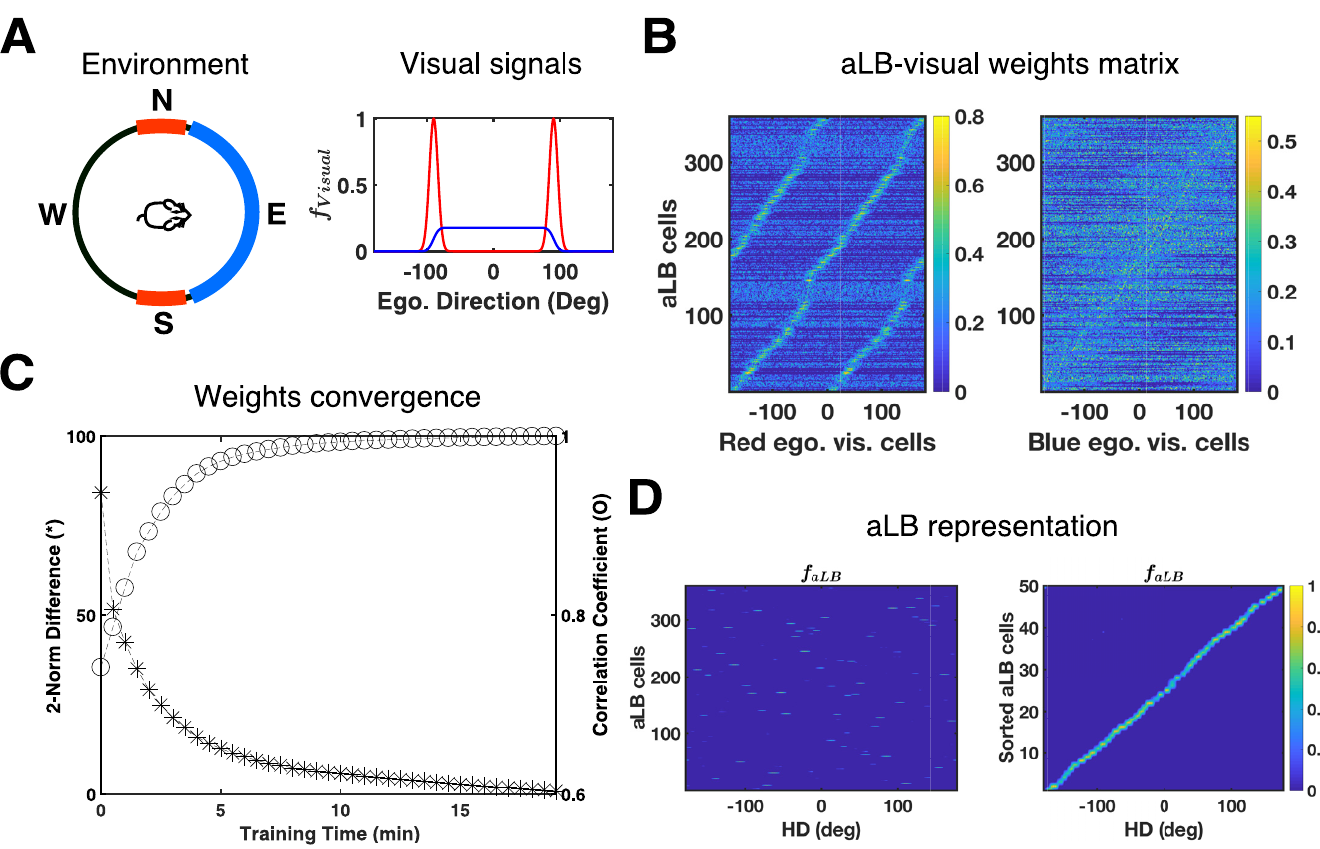
Fig 2. aLB cells express a unimodal representation of landmark bearing via modified OSA. (A) The landmark configuration and feature-specific V1 input signals (same as Fig 1B) for this simulation. Each curve corresponds to the visual cue with the same ‘color’. (B) Sorted weights to aLB cells from visual cortical cells responding to the ‘red’ feature (left) or the ‘blue’ feature (right). The left figure indicates that aLB cells learn a bimodal profile with ‘red’ visual cells due to the conflicting ‘red’ cue. Warmer colors represent stronger synaptic connections. V1 cells are labelled by their own preferred egocentric directions. aLB cells are sorted according to which V1 cells they receive the maximum weight from. (C) The convergence of synaptic weights during learning. The asterisk stands for the two-norm (Euclidean distance) of the difference, while the circular marks stand for the Pearson correlation coefficient, between the vectors of current and final weight matrices. (D) The global representation of aLB cells (labelled by positive numbers on the y-axis) shows sparsity and unimodality during the testing phase (left). Sorting aLB cells according to the HD with maximum firing rate correlation (right) shows that aLB cells have a unimodal firing profile and cover the entire range of egocentric bearings, despite not following any one visual cue alone. Warmer colors represent higher firing rates. Abbreviations: HD: head direction; aLB: abstract landmark bearing; ego.: egocentric; vis.: visual; f : firing rate.